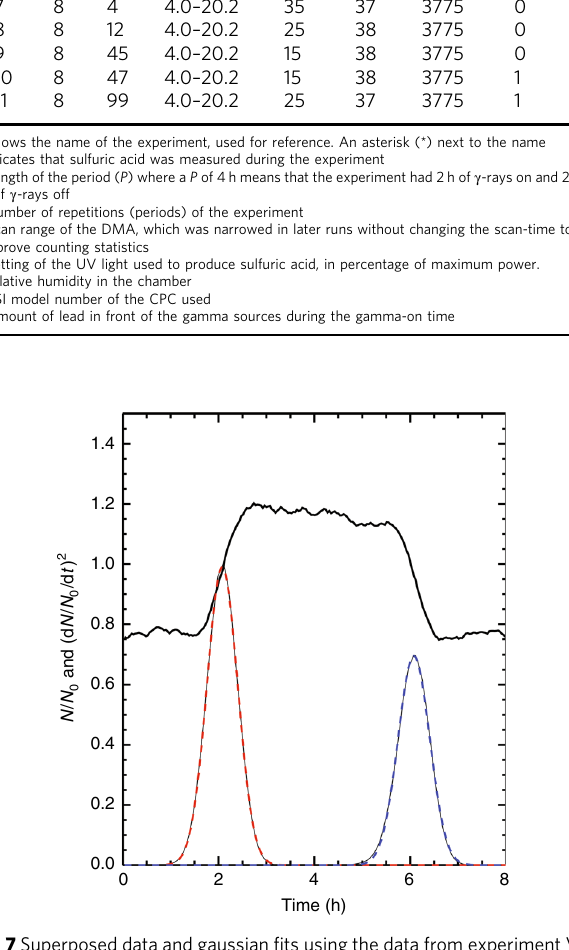
Fig. 7 Superposed data and gaussian fi ts using the data from experiment V9 and SMPS size-bins centered on d = 7.51 nm